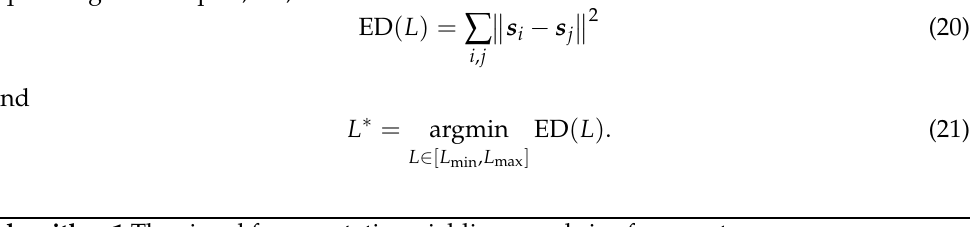
Algorithm 1. In particular, the optimal fragment length L ∗ minimizes the cumulative squared Euclidean distance (ED) between all the pairs of fragments, s i and s j , having the equal length L samples, i.e.,